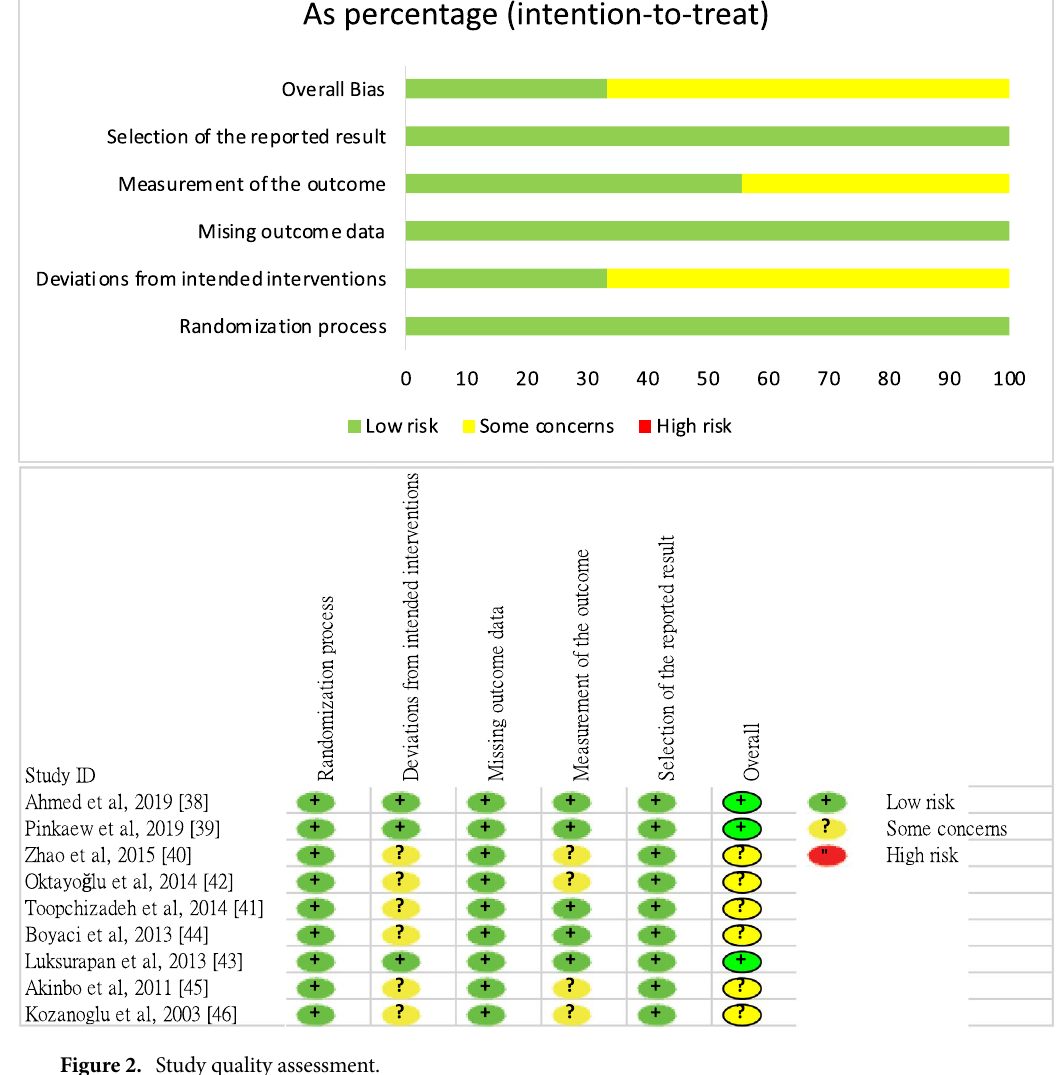
Figure 2. Study quality assessment.